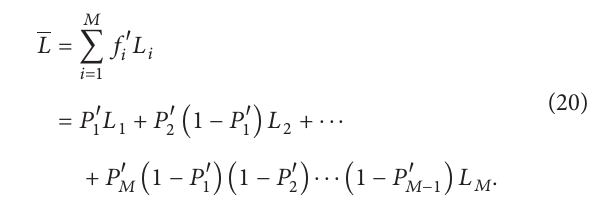
Figure 3: Probabilities that at least one fatigue crack had been nucleated in the i th group of defects ( P ation in the matrix). Fatigue failure frequencies f for initiation of a dominant fatigue crack in the i th group) are numerically equal to the area of the nonoverlapped regions (adapted from